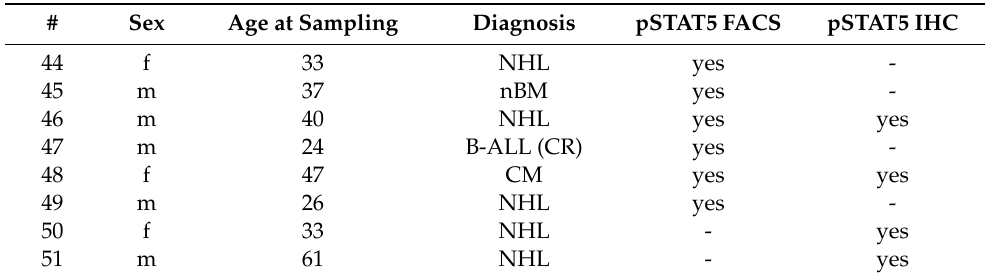
Table A4. Characteristics of control bone marrow